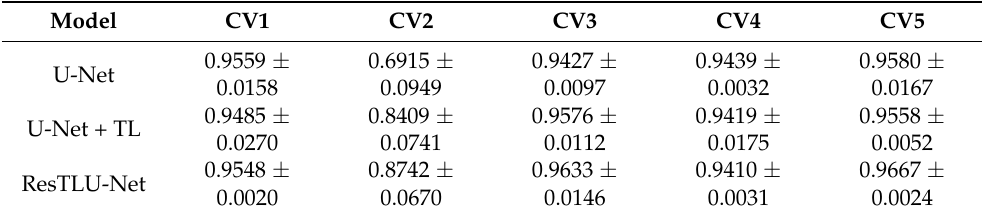
Table 2. Dice coefficient of the five-fold cross-validation